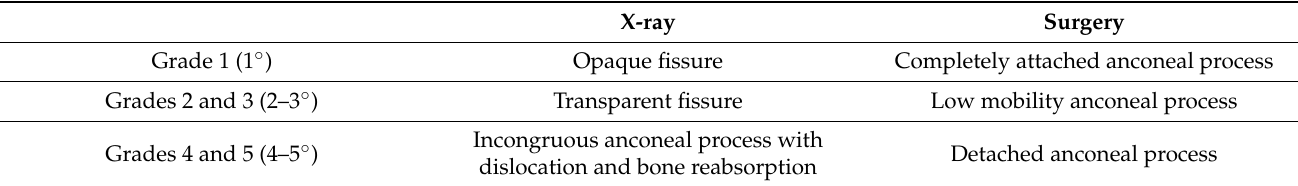
Table 1. Classification of UAP based on Vezzoni and Benjamino